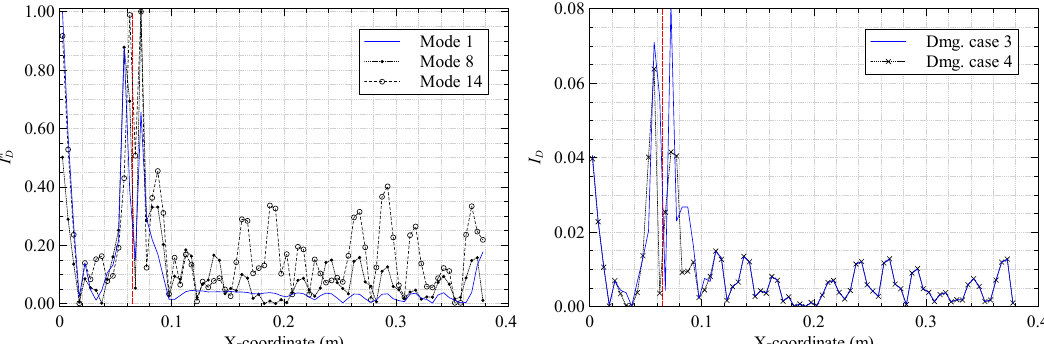
Figure 9. Damage index plots along y = 197.5 mm for ( left ) damage case 3 and ( right ) mode 8.